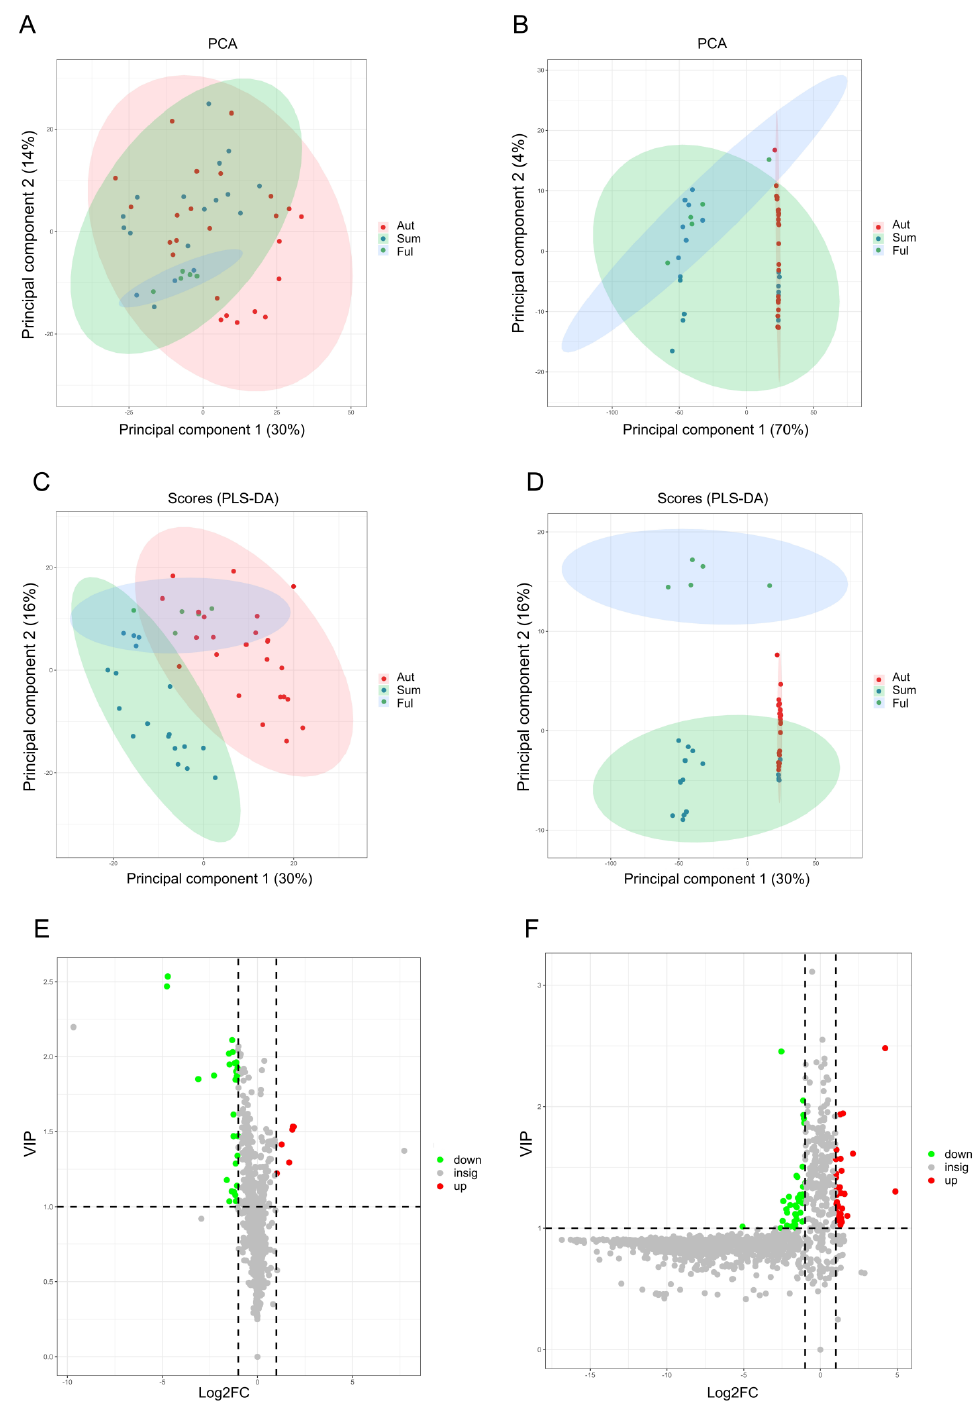
Figure 1. Screening and classification of differential metabolites among summer fruit group (Sum), autumn fruit group (Aut), and full growth fruit group (Ful) in APCI + model and ESI + model. ( A )